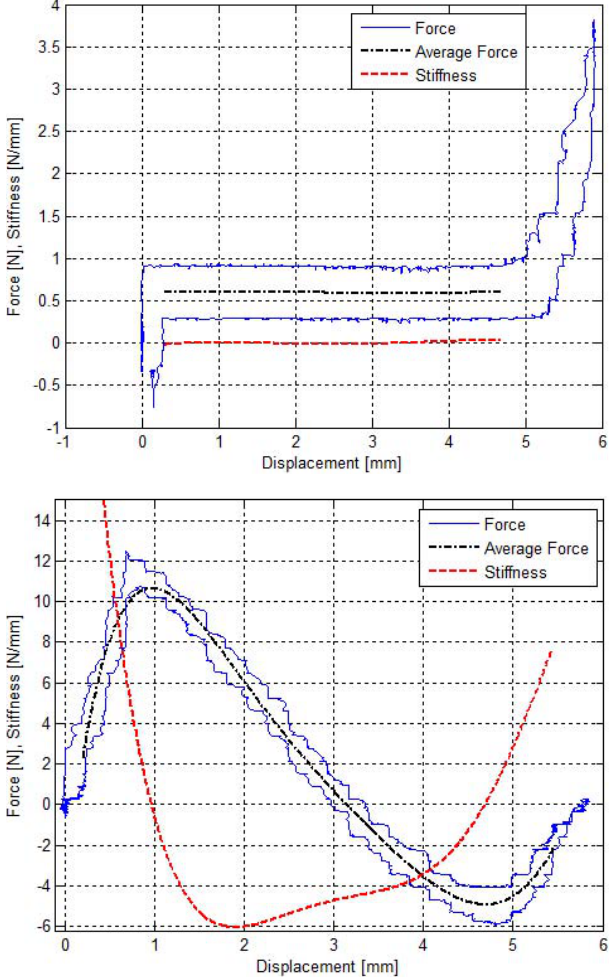
Figure 9. Force-displacement and sti ff ness curves of the SBCG for (a) statically balanced and (b) bi-stable behaviors from the mea- surements; (a) the compliant grasper was balanced with the 0.1mm thickness static balancer and (b) the compliant grasper was balanced with the 0.15mm thicknes static